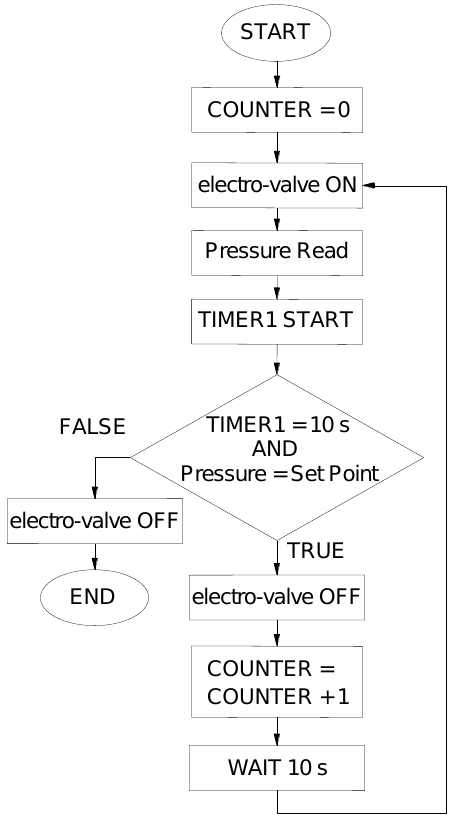
Figure 5. Flow chart of the algorithm used to control the test bench. Tests were carried out according to the isotonic configuration, in absence of an external load. For each value of λ , two muscles were led to rupture, in order to a have a minimal statistical consistency. The range of the values of λ was set considering that for a typical SFM, and for r 0 / l 0 equal to 0.5, λ is equal to 2.17 when the shortening is equal to 10%. Moreover, the maximum value of λ was set equal to 3 considering the maximum value of the static stress of the silicone